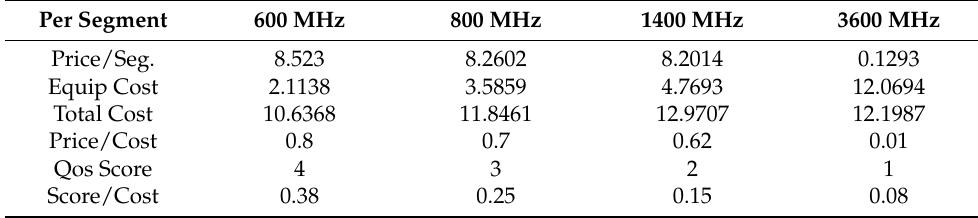
Table 3. Quality features and costs of the